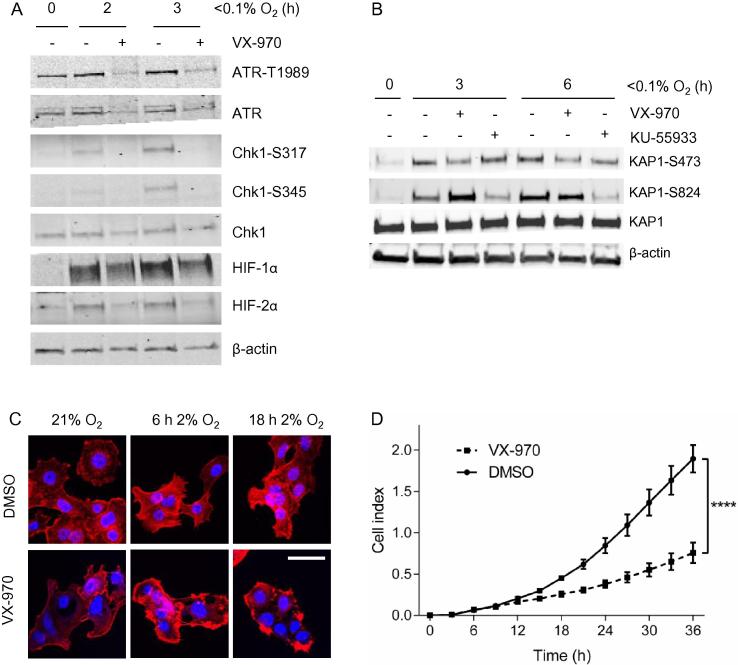
VX-970 inhibits ATR-mediated signaling in OE21 cells exposed to hypoxia. OE21 cells were treated with VX-970 (1 μM) and then exposed to hypoxia (<0.1% O2) for the times indicated. Western blotting was then carried out using the antibodies indicated, β-actin was used as a loading control (A). (B) OE21 cells were treated with VX-970 (1 μM) or KU-55933 (10 μM) and then exposed to hypoxia (<0.1% O2) for the times indicated. Western blotting was then carried out. (C) OE21 cells were treated with VX-970 (1 μM) and exposed to a milder level of hypoxia (2% O2) for the times indicated. Cells were fixed and stained with phalloidin to visualize F-actin (scale bar = 50 μm). (D) OE21 cells migration in response to VX-970 treatment in hypoxia (2% O2) was analyzed by xCELLigence. Results shown are mean ± SEM (n = 3). Significance: Two-way ANOVA test, ****P < 0.0001.